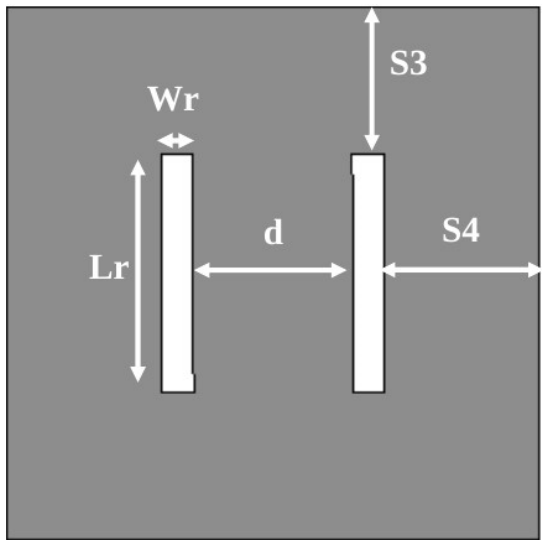
Figure 8. Patch with PRSs structure.